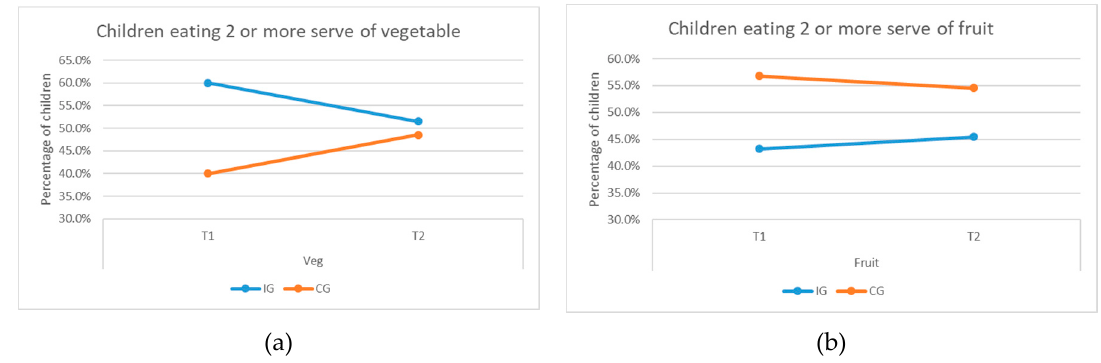
Figure 7. Percentage of children eating two or more servings of (a) vegetables and (b) fruits.